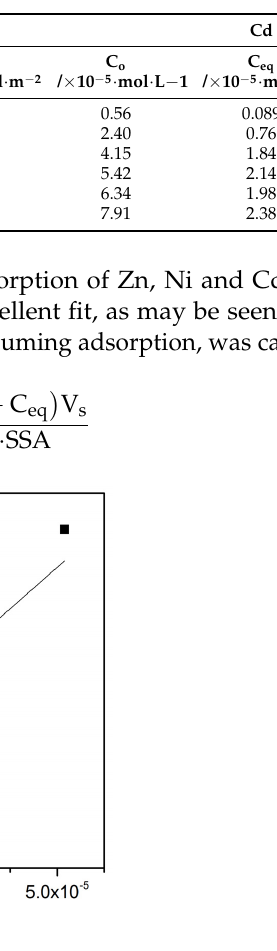
Table 8. Initial concentrations, C o ; equilibrium concentration, C eq ; and surface concentration, Γ , for each metal adsorption on calcite. (Ionic strength of 0.15 M of NaCl).